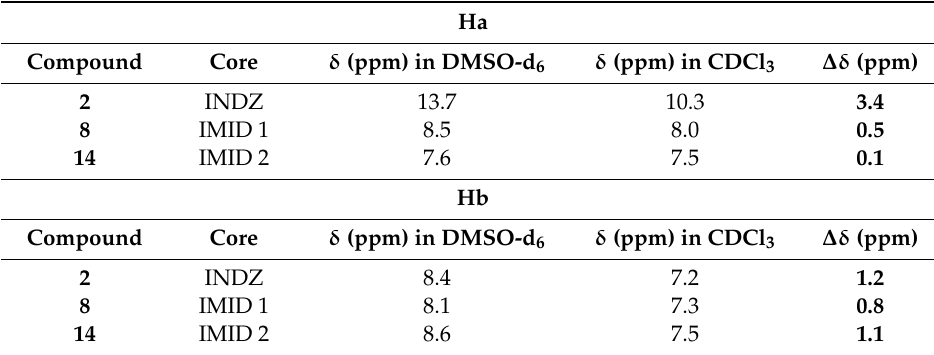
Table 5. Chemical shifts of Ha and Hb observed in the 1 H-NMR spectra of 2 , 8 and 14 derivatives (0.3 mM) in CDCl 3 and DMSO-d 6